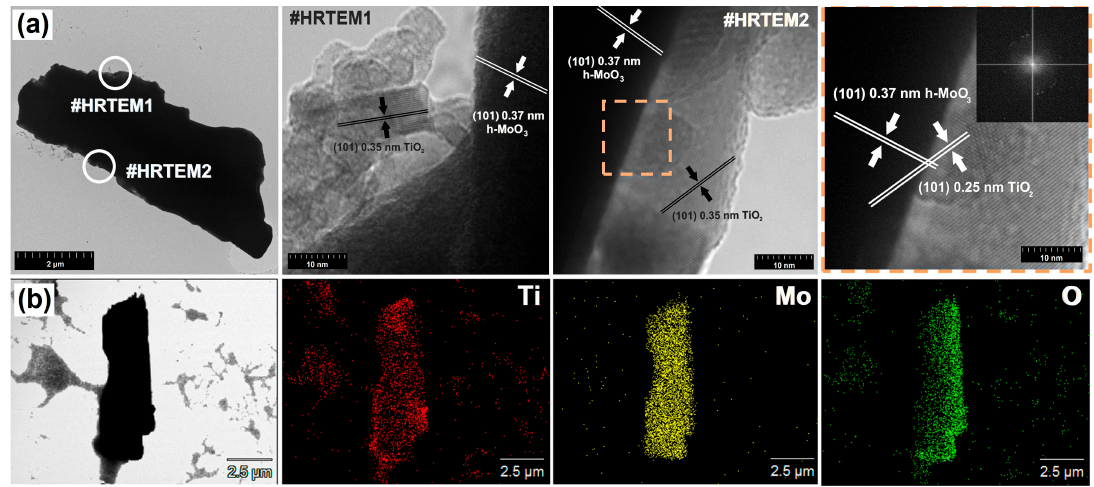
Figure 5. Microstructure of sample Ti8Mo2 in ( a ) HRTEM images and ( b ) EDS mapping with elemental map of titanium, molybdenum and oxygen.